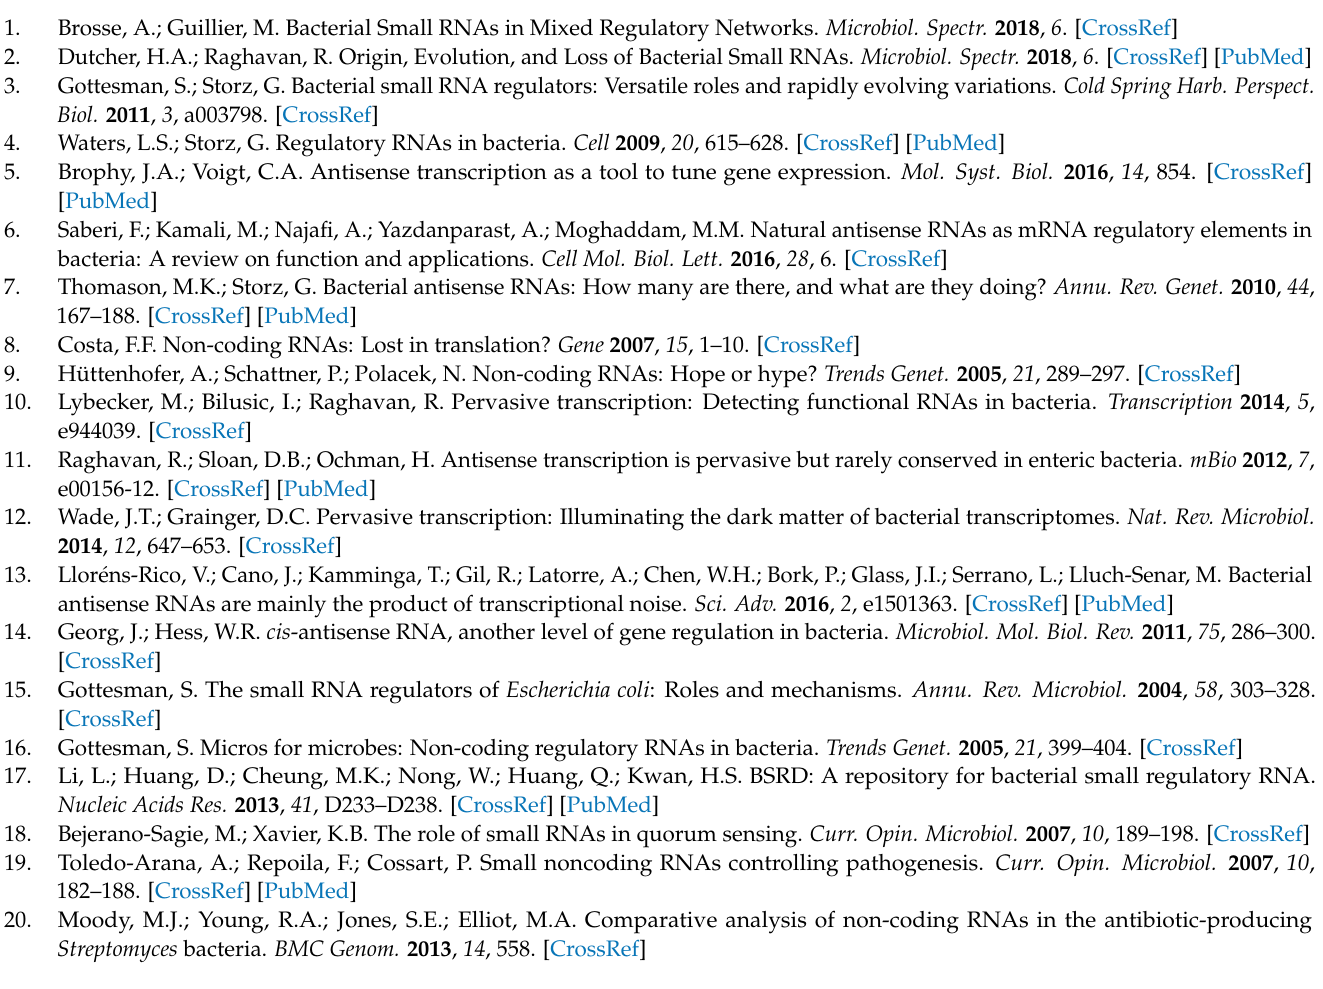
gene expression. Table S13. Differential expression (log2Fold Change) of Class I asRNA obtained comparing w.t., Ω pirA and Ω pirA rpoB(R) strains, according the 4 time points (48, 72, 96 and 120 h) and Ω pirA, and Ω pirA rpoB(R) mapping